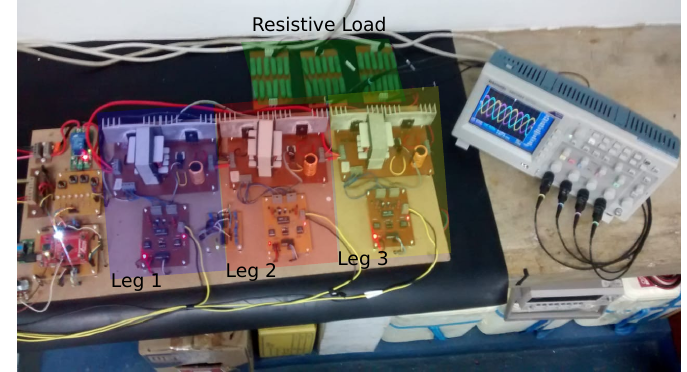
Figure 23. Prototype with resistive